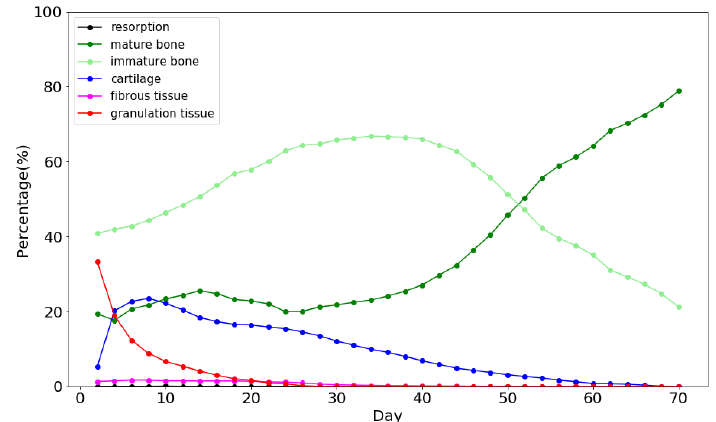
Figure 3. Percentage of various tissue phenotype in each day during the short-term bone healing process.